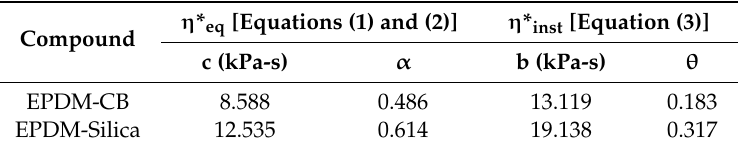
Table 2. Power Law Parameters for γ -dependences of η * eq and η * inst